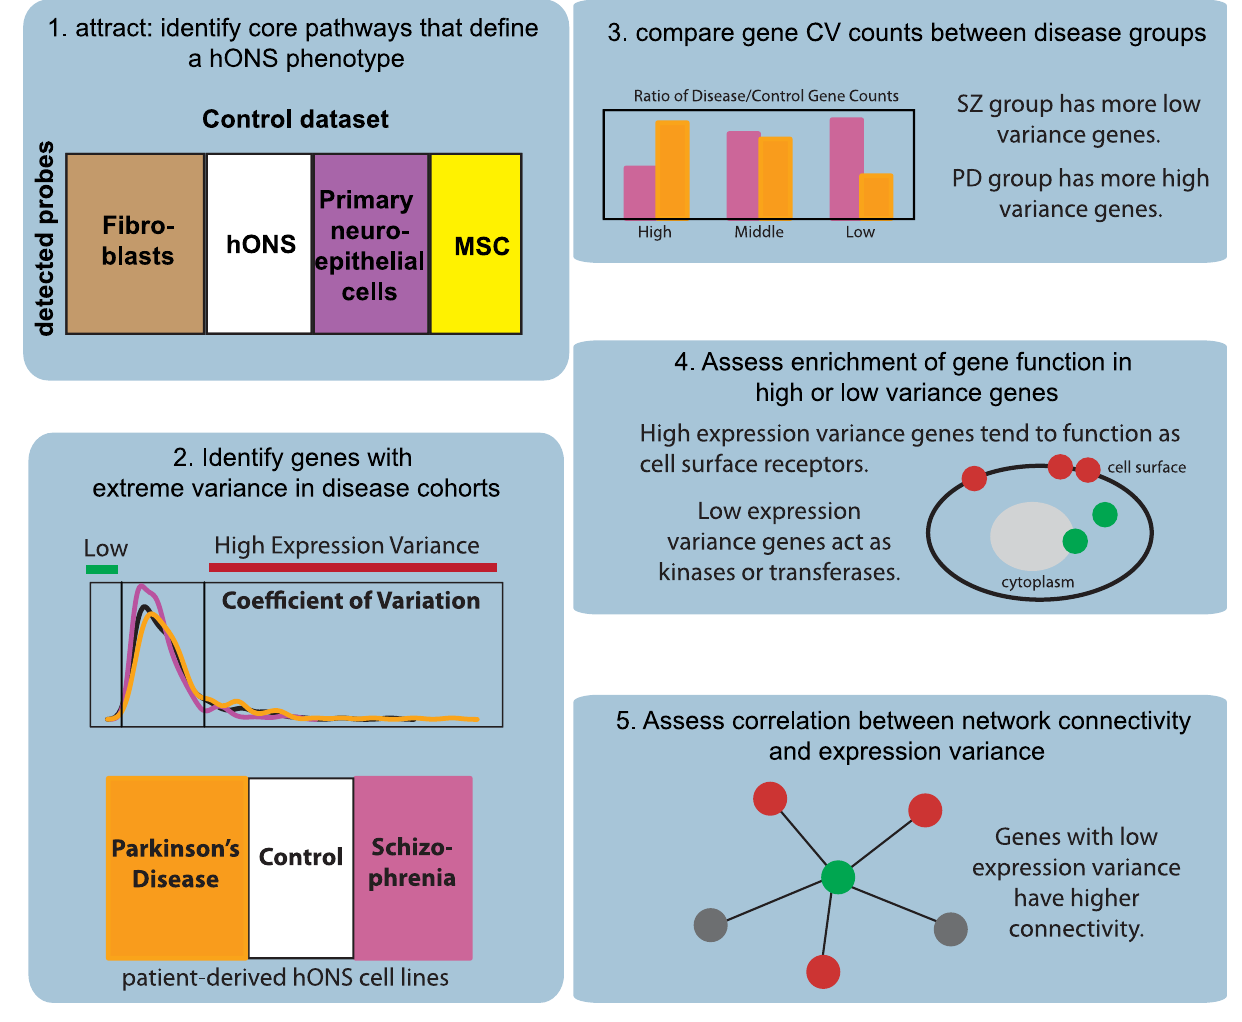
Figure 1. Overview of analysis pipeline.